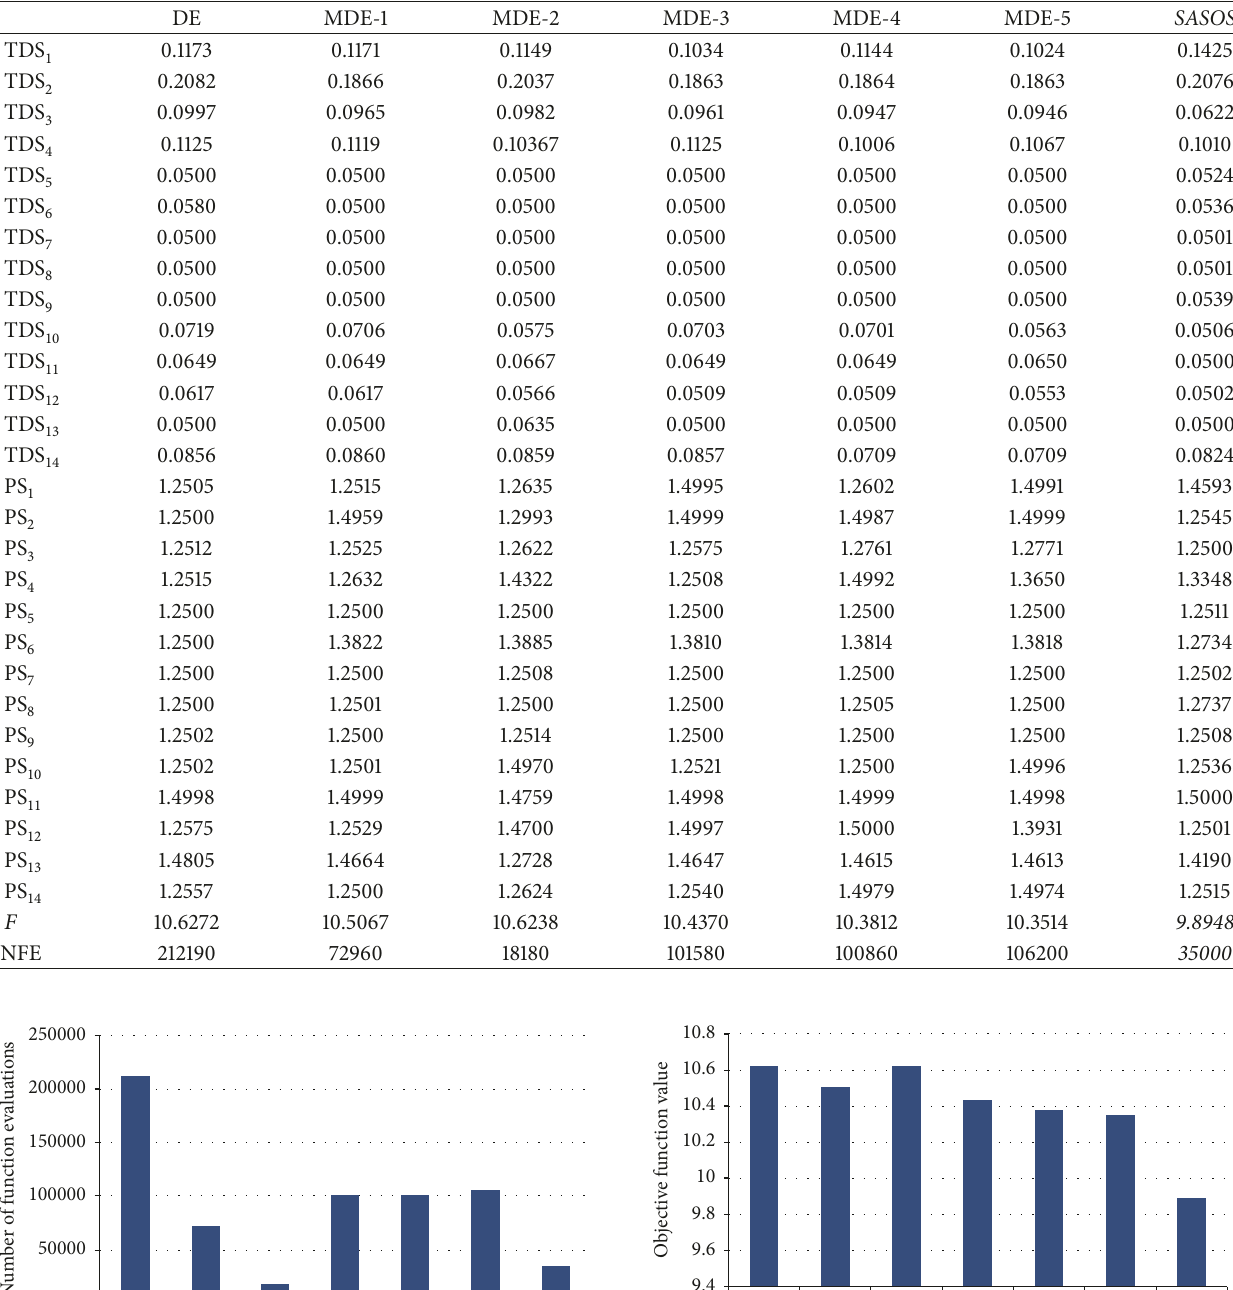
Table 3: Optimal values of design variables, objective values, and function evaluations obtained by SASOS, DE, and modified DE: IEEE 6-bus system.